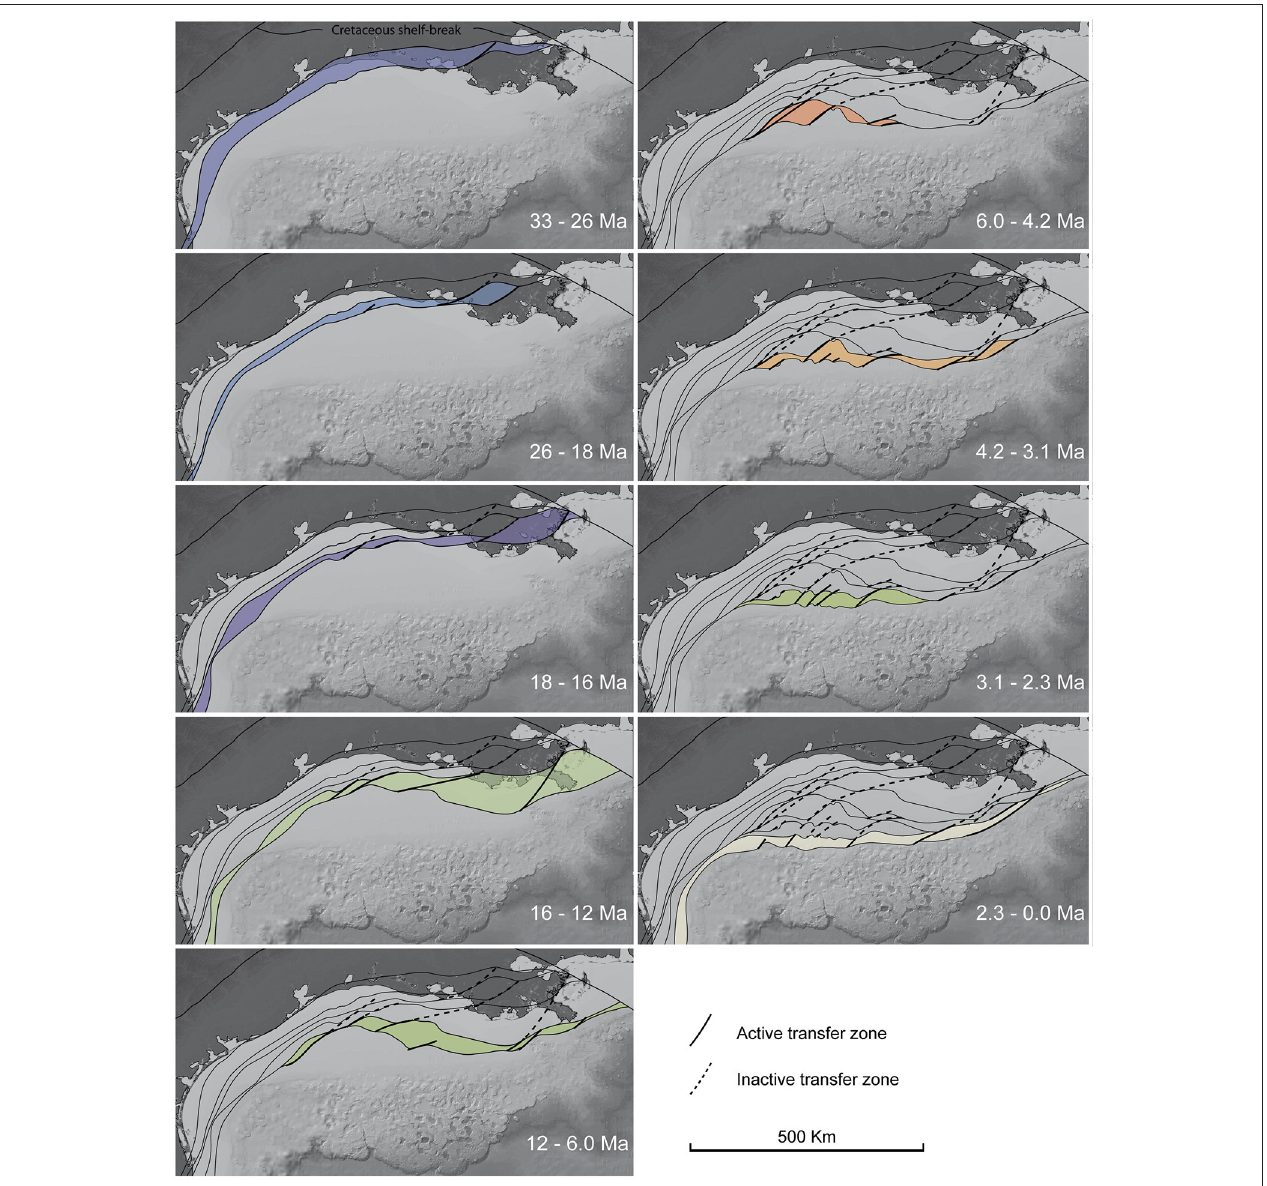
FIGURE 3 | Step-by-step growth of the continental shelf in the northern Gulf of Mexico. Shelf break contours, colors of depositional episodes (growth increments) and ages like in Figure 2 . Solid black lines: Transfer zones active during a shelf growth increment; dashed lines: trace of transfer zones that developed during previous shelf growth